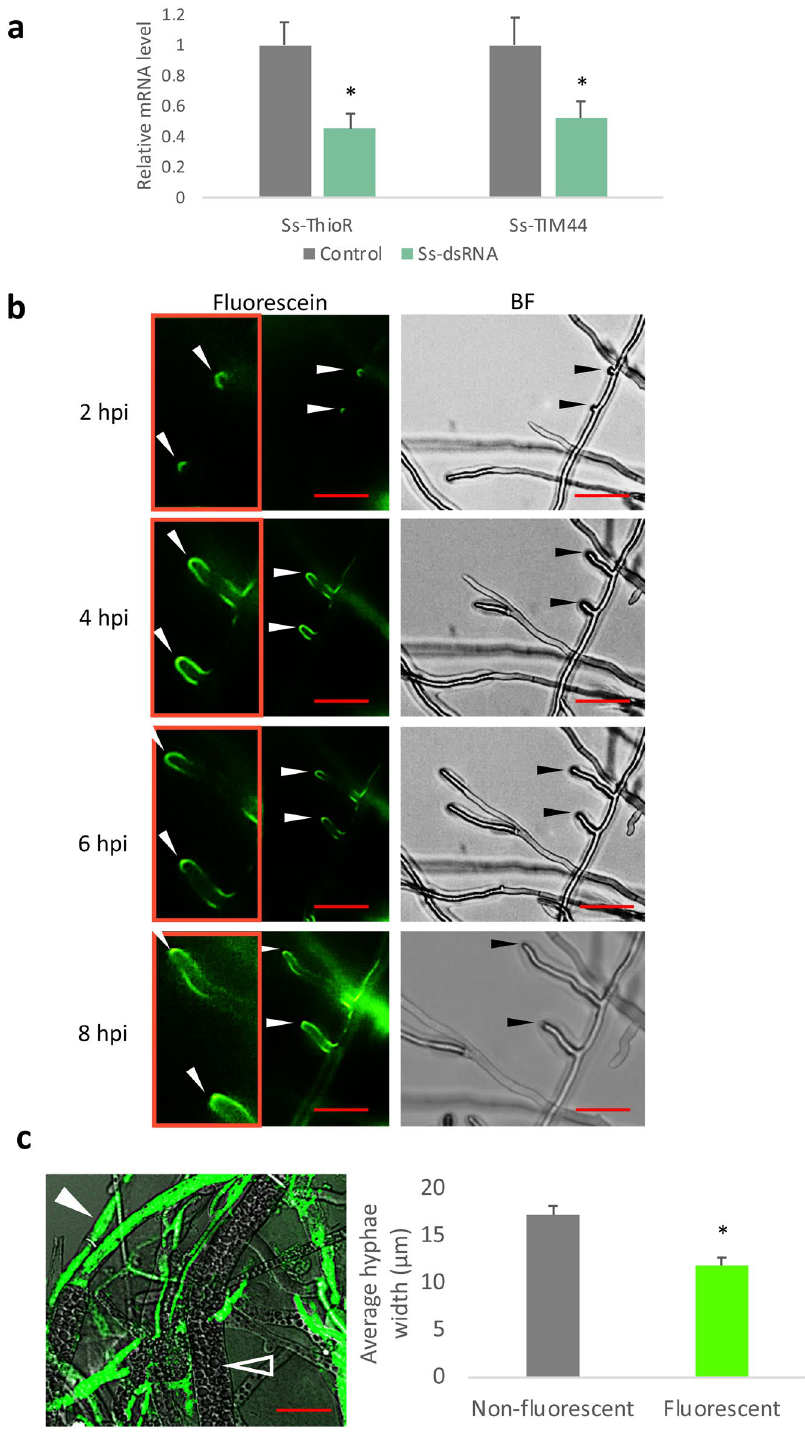
Figure 1. Uptake of dsRNA by Sclerotinia. ( a ) In vitro cultures were treated with 500 ng/mL of dsRNA targeting two Sclerotinia genes, Ss-ThioR and Ss-TIM44. Transcript abundance was measured after 48 h. Asterisk denotes significant reduction in transcripts, relative to the controls (one-tailed t-test, p < 0.05 from three independent biological replicates) ( b ) Detection of fluorescein-tagged Ss-ThioR dsRNA in newly germinated hyphae from ascospores. Growing hyphae were imaged using the ImageXpress platform. At each time point, representative bright-field (BF) images (right) reveal growing hyphae (arrow heads), and their fluorescence is visualized in the middle panel. Enlarged images of the hyphal tips are shown in the left panel (Scale bars: 40 µm). ( c ) Three day-old Sclerotinia inoculated with fluorescein-labelled dsRNA show different levels of fluorescence 8 h later. (Hollow arrow with white border: mature, vacuolated hyphae; white arrow: younger hyphae, more prone to uptake). The widths of all hyphae were measured at their midpoints, and were scored for absence or presence of fluorescence (Scale bars: 20 µm). Asterisk denotes significant difference in the width of fluorescent hyphae, relative to non- fluorescing hyphae (one-tailed t-test, p < 0.05; n = 40 hyphae of each